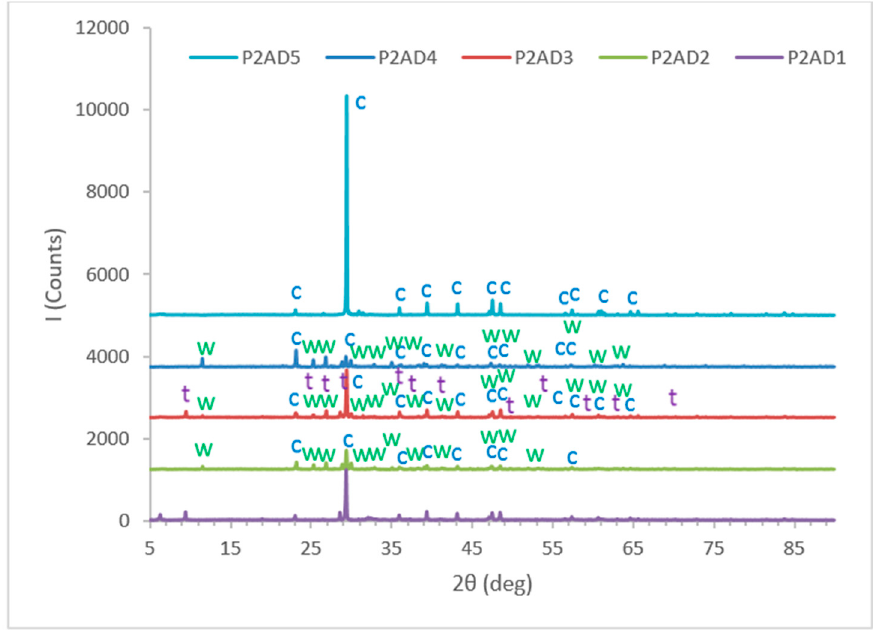
Figure 2. X-ray diffraction patterns of structural adhesives used in second phase. Figure 2. X-ray di ff raction patterns of structural adhesives used in second